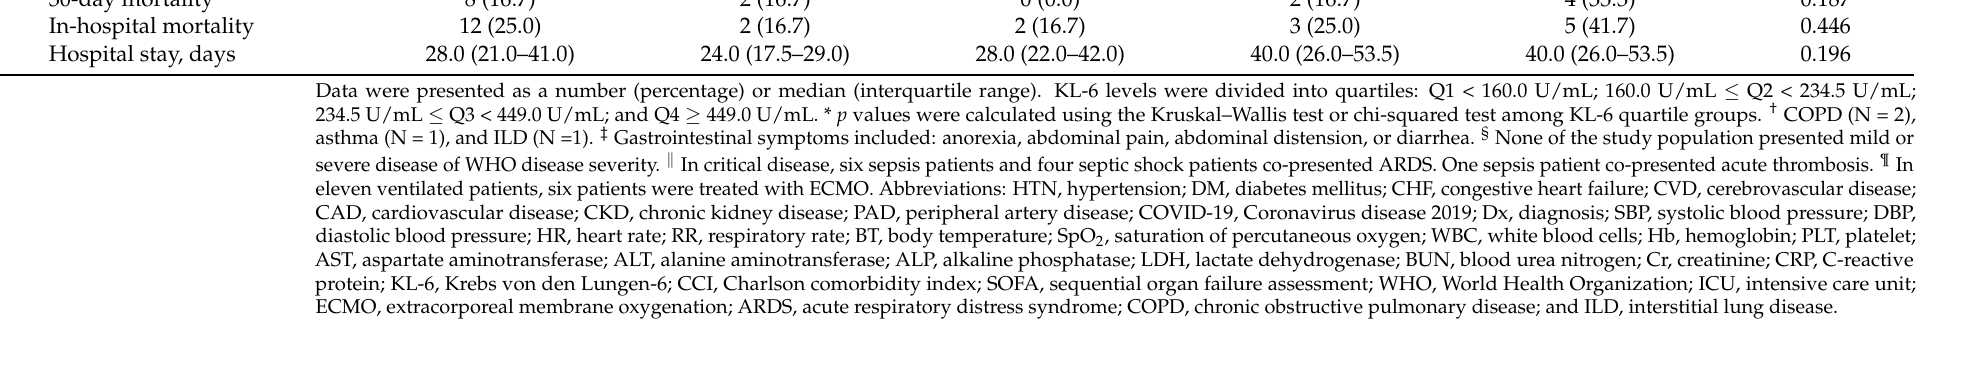
Table 2. Age, initial KL-6 level, CCI, and critical disease according to clinical